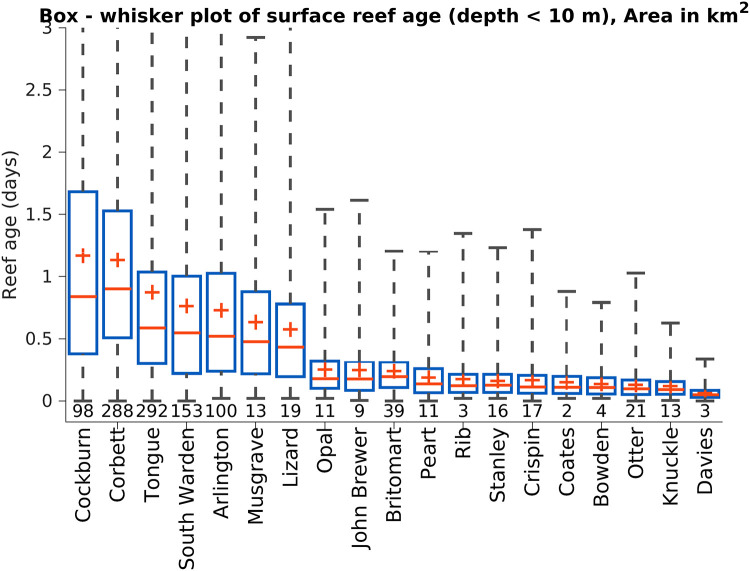
Distribution of reef age in surface waters.Statistics of surface reef age in shallow waters (depth < 10 m) of 19 reefs of the GBR, sampled every three hours in each shallow model grid cell between 30 Jan 2017—28 Feb 2017. The number at the base of each plot is the surface area (km2) of the reef with a depth less than 10 m. Blue boxes extend from the 1st to 3rd quartiles, red crosses are mean, red lines the median and the whiskers show the range.